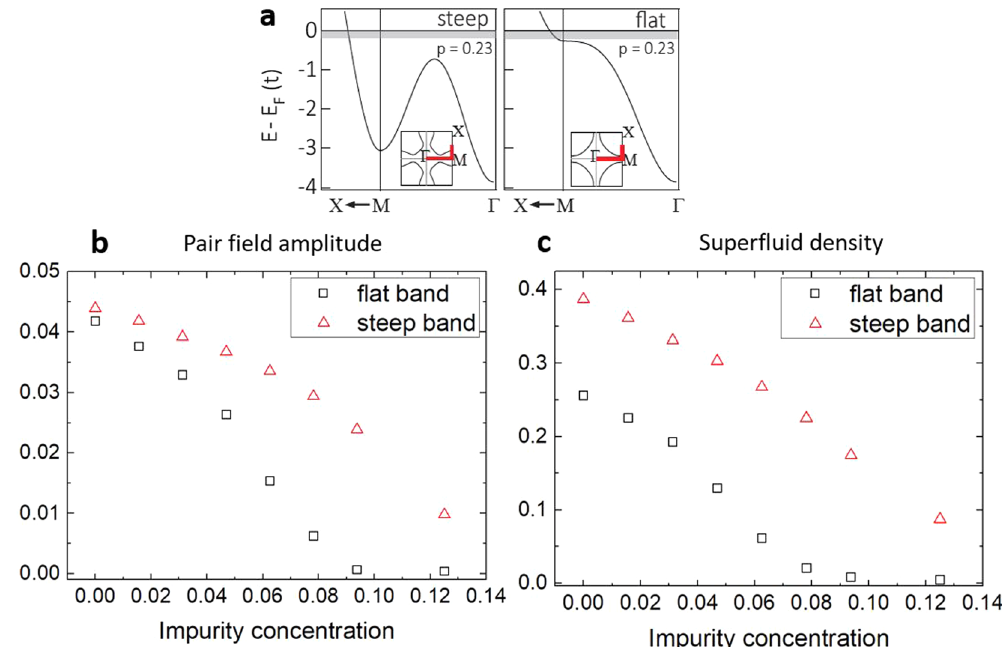
Fig. 6 The comparison between fl at and steep bands. The spatially averaged zero-temperature d -wave pair- fi eld amplitude ( b ) and super fl uid phase stiffness ( c ) computed with the two different band structures shown in ( a ). Results for the partially fl at band are shown as the black squares and for the steep band by the red.